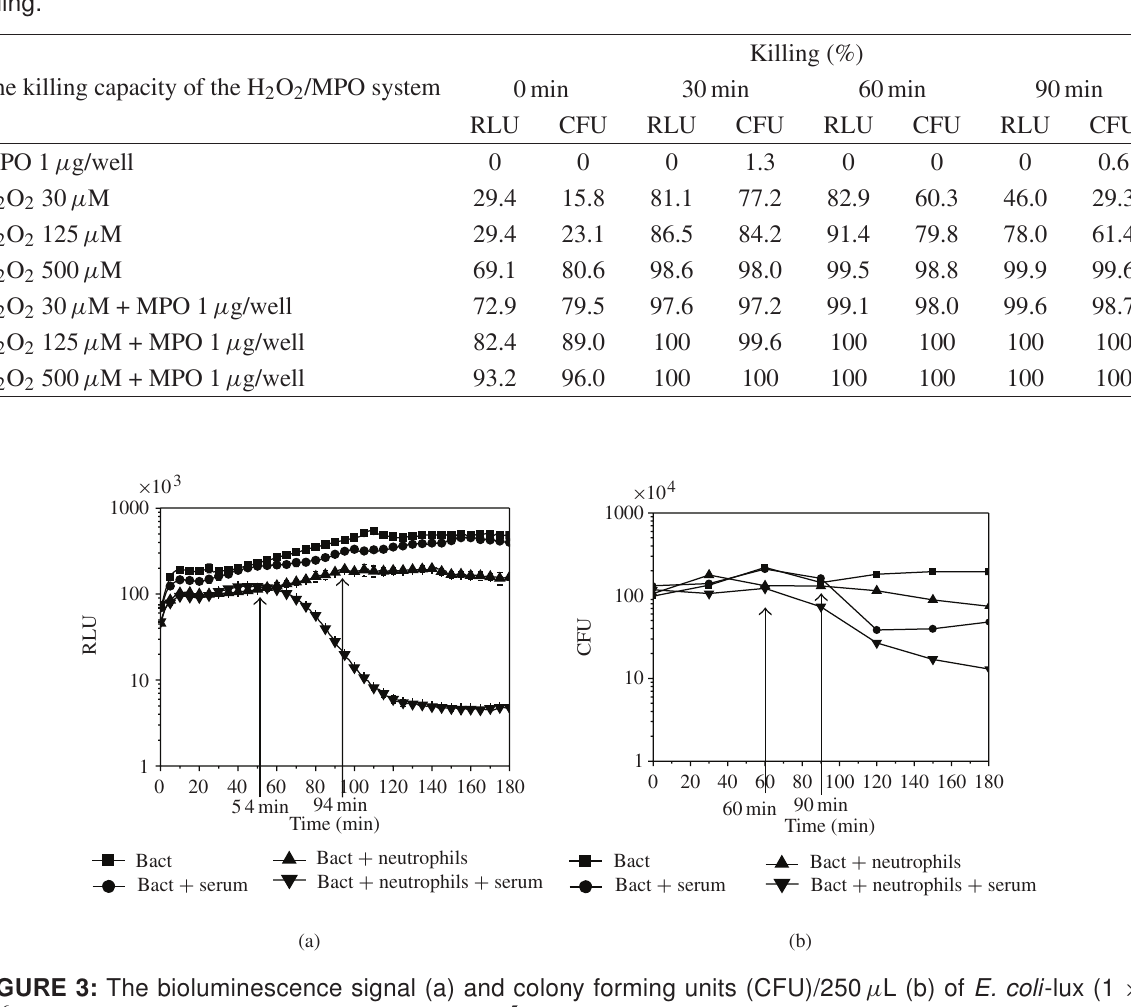
TABLE 1: The killing capacity of the H 2 O 2 /MPO system. The killing capacity of the H 2 O 2 /MPO system, both from the RLU and CFU analysis, was calculated by setting the values from the bacterial well as a 0 % of killing.